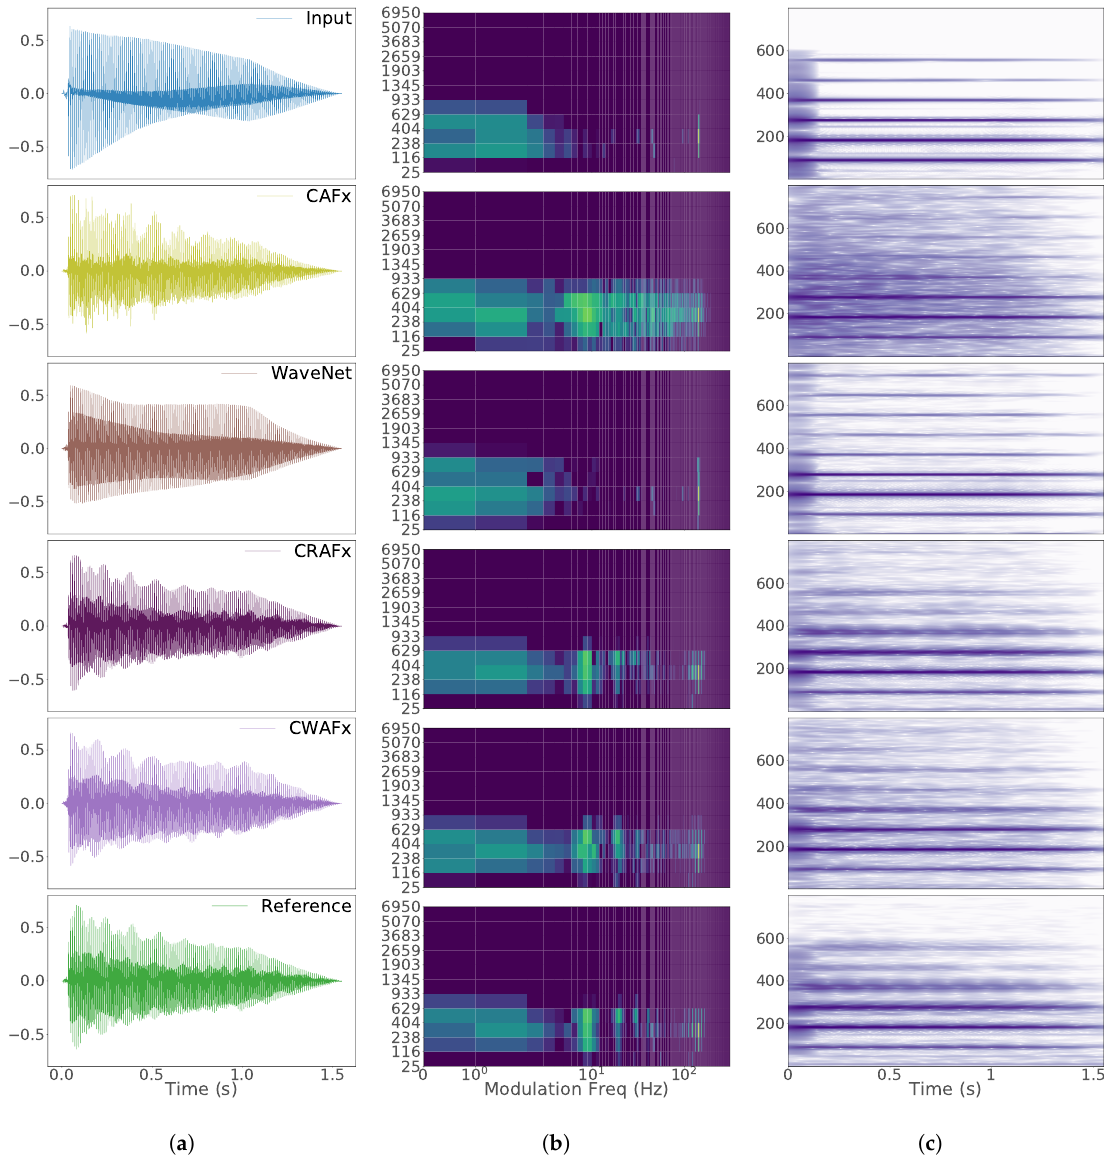
Figure 10. Results with selected samples from the test dataset for the Leslie speaker woofer-tremolo tasks. ( a ) Waveform, ( b ) modulation spectrum and ( c ) spectogram. Vertical axes represent amplitude, Gammatone frequency (Hz) and FFT frequency (Hz),